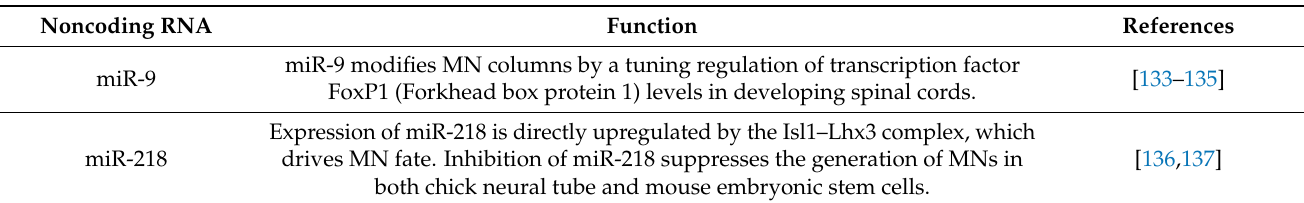
Table 4. Noncoding RNAs and their functions in MN